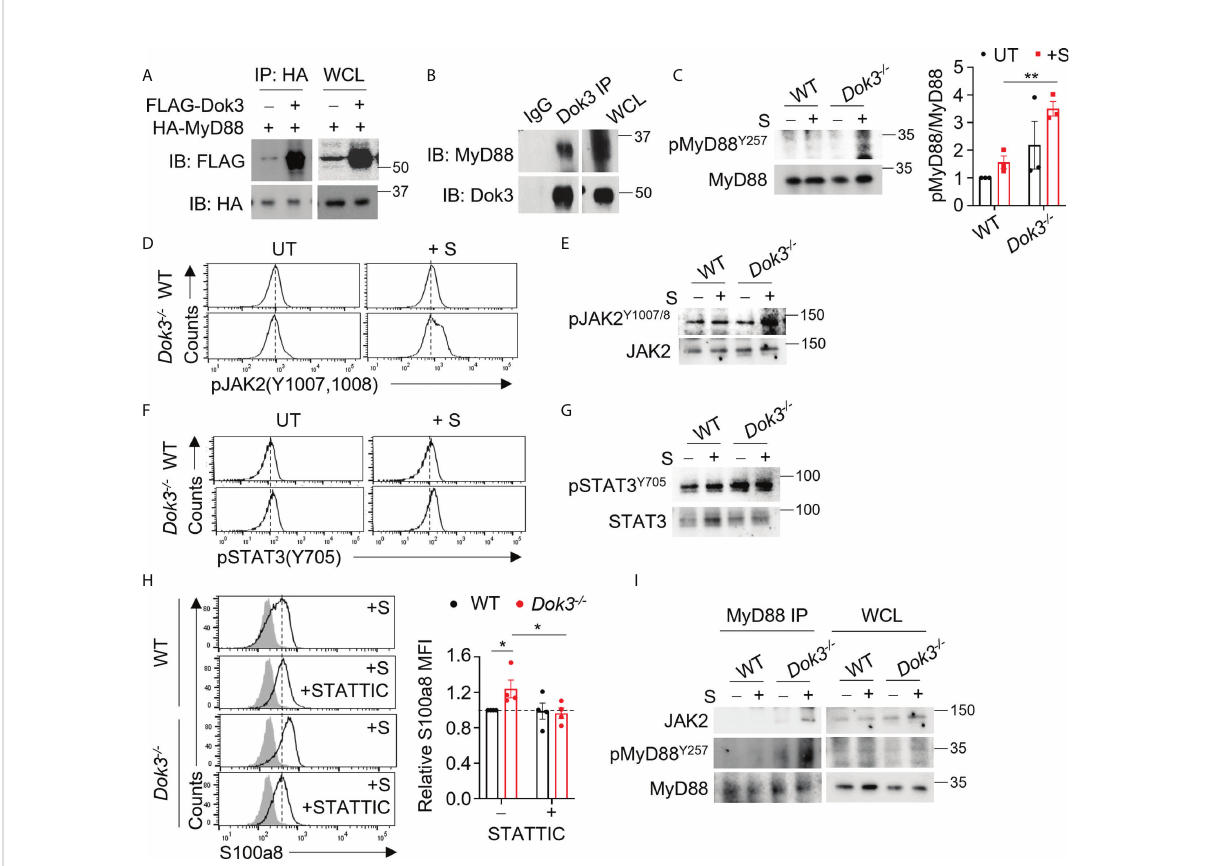
FIGURE 2 Dok3 mediates de-phosphorylation of MyD88 Y257 and suppression of JAK2-STAT3 signaling in response to SARS-CoV-2 S protein stimulation. (A) HEK293T cells were transfected with HA-tagged MyD88 and FLAG-tagged Dok3. Cell lysates were IP with anti-HA antibody. Precipitates and WCL were immunoblotted with anti-HA and anti-FLAG antibodies. Data shown are representative of 3 independent experiments. (B) Cell lysates from WT neutrophils were IP with anti-Dok3 or IgG control. Precipitates and WCL were probed for Dok3 and MyD88. Data shown are representative of 3 independent experiments. (C) Immunoblot analyses of pMyD88(Y257) and total MyD88 in WT and Dok3 -/- neutrophils treated with or without S protein for 15 mins. Data shown are representative of 3 independent experiments. Bar graph depicts quanti fi cation of pMyD88/MyD88 signals from immunoblot. **p = 0.005, unpaired two-tailed Student ’ s t-test. (D, F) Flow cytometric analyses of (D) pJAK2 (Y1007,1008) and (F) pSTAT3(Y705) in WT and Dok3 -/- neutrophils treated with or without S protein for 3h. Histograms were pre-gated on singlet, Ly6G + cells. Data shown are representative of 3 independent experiments (n = 3). (E, G), Immunoblot analyses of (E) pJAK2(Y1007,1008), total JAK2, (G) pSTAT3(Y705) and total STAT3 in WT and Dok3 -/- neutrophils treated with or without S protein for 15 mins. Data shown are representative of 3 independent experiments. (H) Flow cytometric analysis of S100a8 expression in WT and Dok3 -/- neutrophils following 3h stimulation with S protein in the presence or absence of STATTIC. Histograms were pre-gated on singlet, Ly6G + cells. Filled histogram represents isotype control. Bar graph depicting MFI of S100a8 fl uorescence relative to untreated WT neutrophils. Data is shown as mean ± S.E.M. (n = 4, 4 independent experiments). *p = 0.05, unpaired two-tailed Student ’ s t-test. (I) Co-IP analysis of WCL from WT and Dok3 -/- neutrophils treated with or without S protein for 15 mins, and IP with anti-MyD88. Precipitates and WCL were probed for JAK2, pMyD88(Y257) and MyD88. Data shown are representative of 3 independent